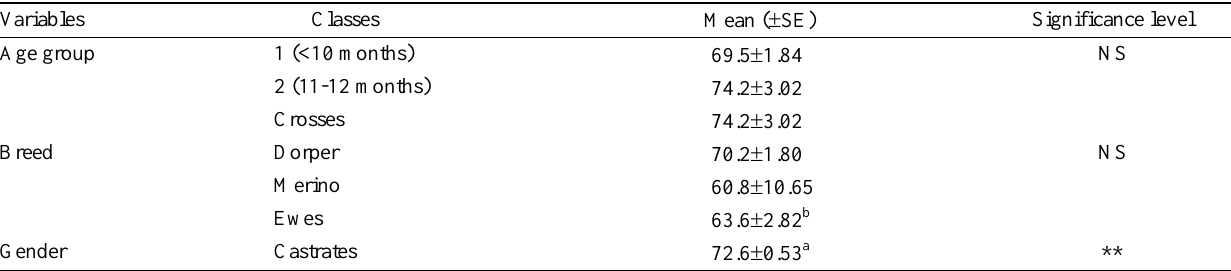
Gender ** Means in the same row with different superscripts are significantly different at p<0.05.